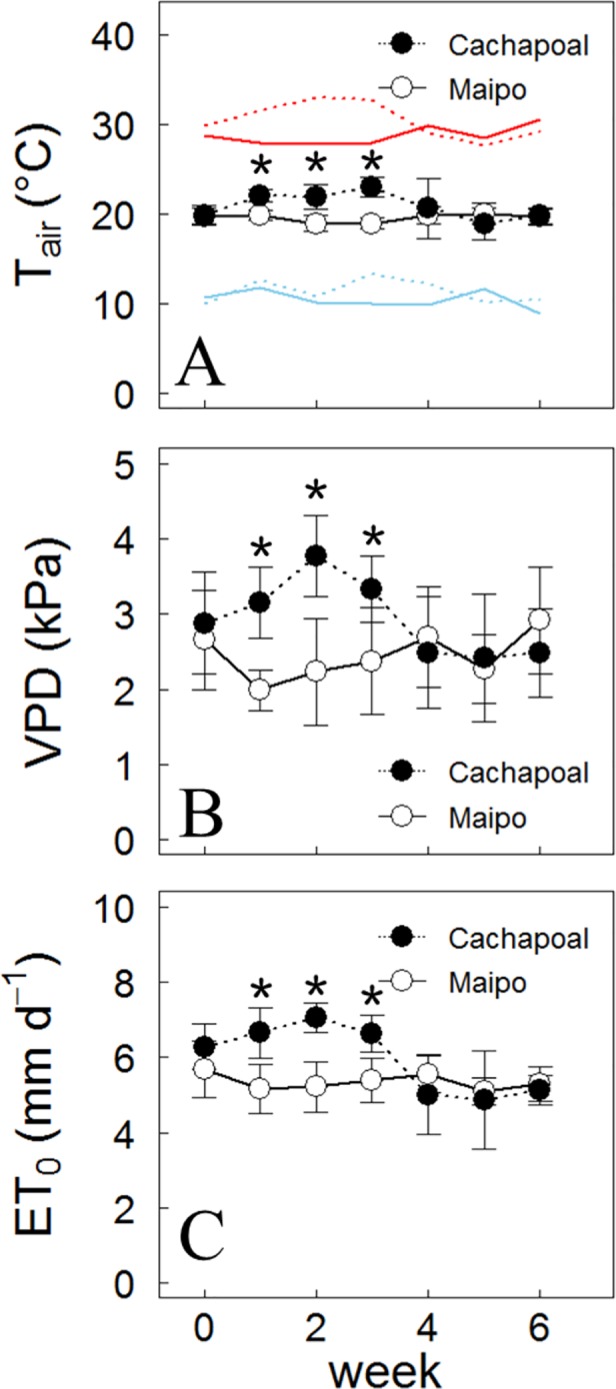
Climate variables during drought experiment. Weekly mean values of (A) air temperature, (B) vapor pressure deficit (VPD), and (C) reference evapotranspiration (ET0) through drought assays. Black symbols with dotted lines correspond to climate data from a season in the Cachapoal Valley and white symbol with continuous lines to a Maipo Valley season. Red and blue lines in A depicts the maximum and minimum temperatures. Mean weekly values ± S.D. are displayed. *Denotes significant differences between valleys (p < 0.05)